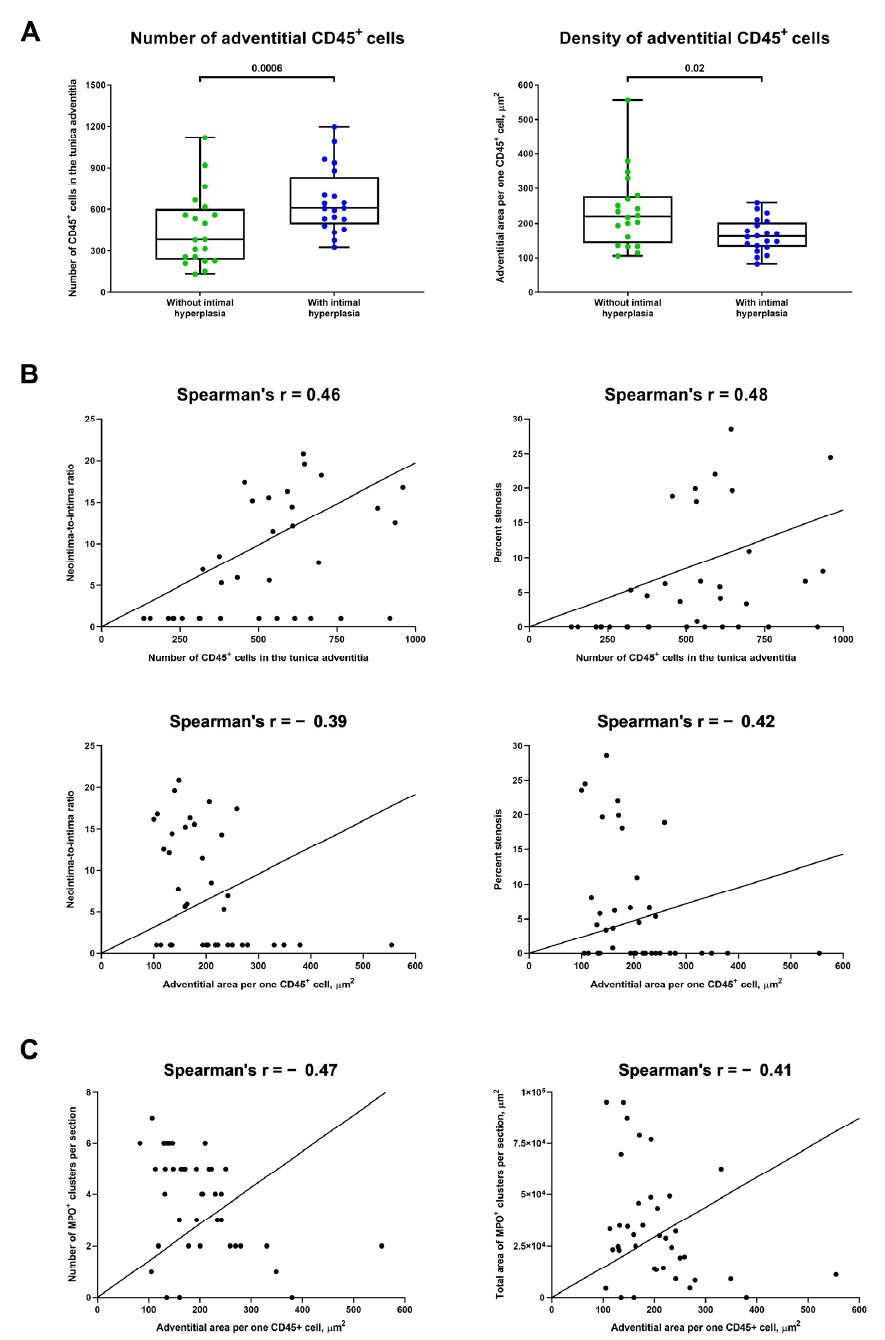
Figure 4. Number and density of immune cells are associated with the development of IH and expansion of MPO + clusters. ( A ) Quantitative analysis of number and density of CD45 + cells in the tunica adventitia of rats with or without IH in the abdominal aortas 5 weeks upon the balloon angi- oplasty (from the experiment in Figure 3A). Each dot represents an aortic section from one rat. Whiskers indicate range, box bounds indicate 25th–75th percentiles, center lines indicate median. p - values provided above boxes, Mann–Whitney U-test; ( B ) Correlation plots indicate a strong corre- lation of the number of CD45 + cells (top) and their density (bottom) in the tunica adventitia with both measures of intimal hyperplasia (neointima-to-intima ratio, left and percent stenosis, right).